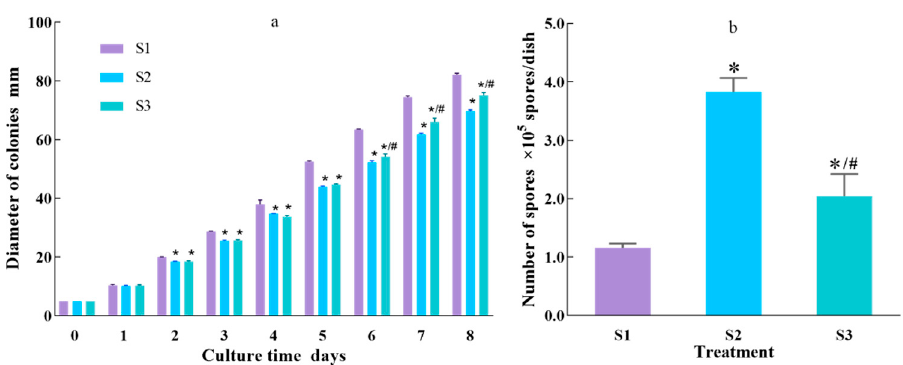
Figure 1. Colony growth and spore number after different treatments. ( a ) is the diameter of colonies and ( b ) is the number of spores (macroconidia). S1 group ( n = 5): inoculation of F. solani on normal PDA; S2 group ( n = 5): inoculation of F. solani on PDA containing 40 µmol/L DPI; S3 group ( n = 5): inoculation of F. solani on PDA containing 40 µmol/L DPI. On the fourth day of cultivation, 5 mL of 0.0012% H 2 O 2 was added to each dish. Data are expressed as the mean ± SD. * p < 0.05 S2 or S3 vs. S1, # p < 0.05 S3 vs. S2.